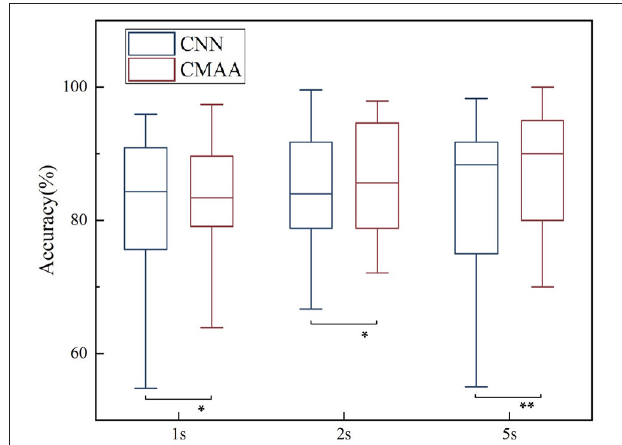
FIGURE 5 | Auditory attention detection performance of the CMAA model for three different decision windows. CNN decoding model is shown as baseline. Significance was calculated using paired t -test (* p <0.05, ** p